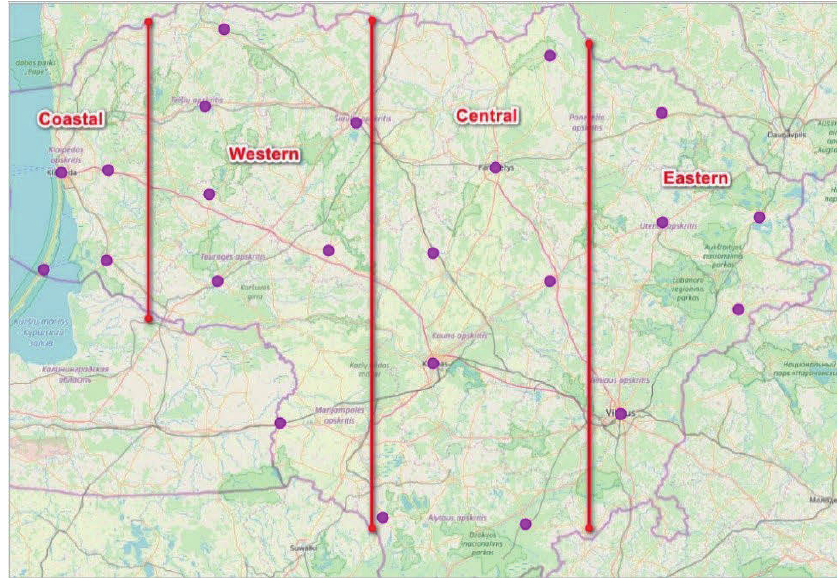
Fig. 2. Regions of hydrometeorological